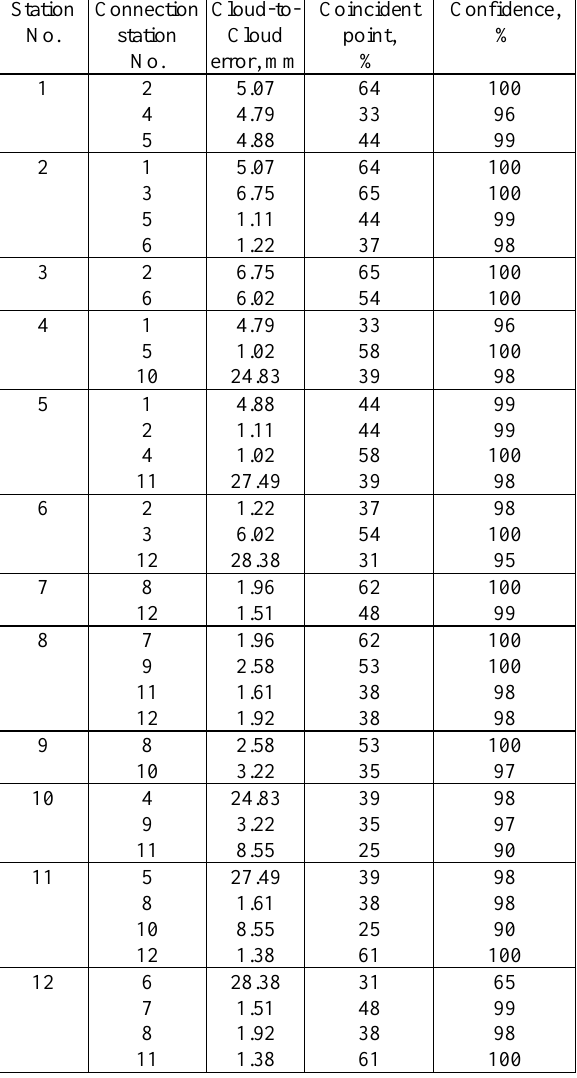
Table 2. Registration Report using Scans data Interconnected point clouds of stations 1-6 on the right side of embankments do not exceed 7 mm error and number of total Figure 6. Model of the bridge uploaded in to the project of points varies from 30-65%. The reliability of results is high embankments. from 95 to 100%. When point clouds of stations 10-12 on the left side of embankments were included in to process the connection errors increase from 24 to 27 mm and the number of total points does not exceed 39%. The reliability of results remains high from 65 to 98%. The results allow us to conclude that to ensure accuracy of the 3D model it is necessary to be accurate and stations have to be close to each other. However,